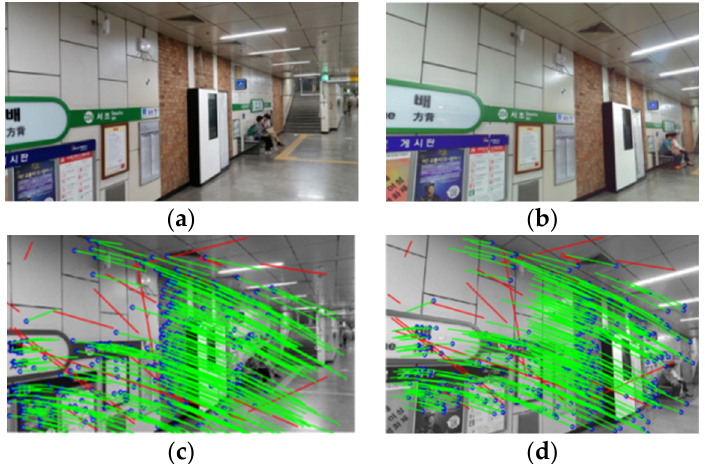
Table 6. Accuracy in ETRI building with Samsung Galaxy S7 Edge.